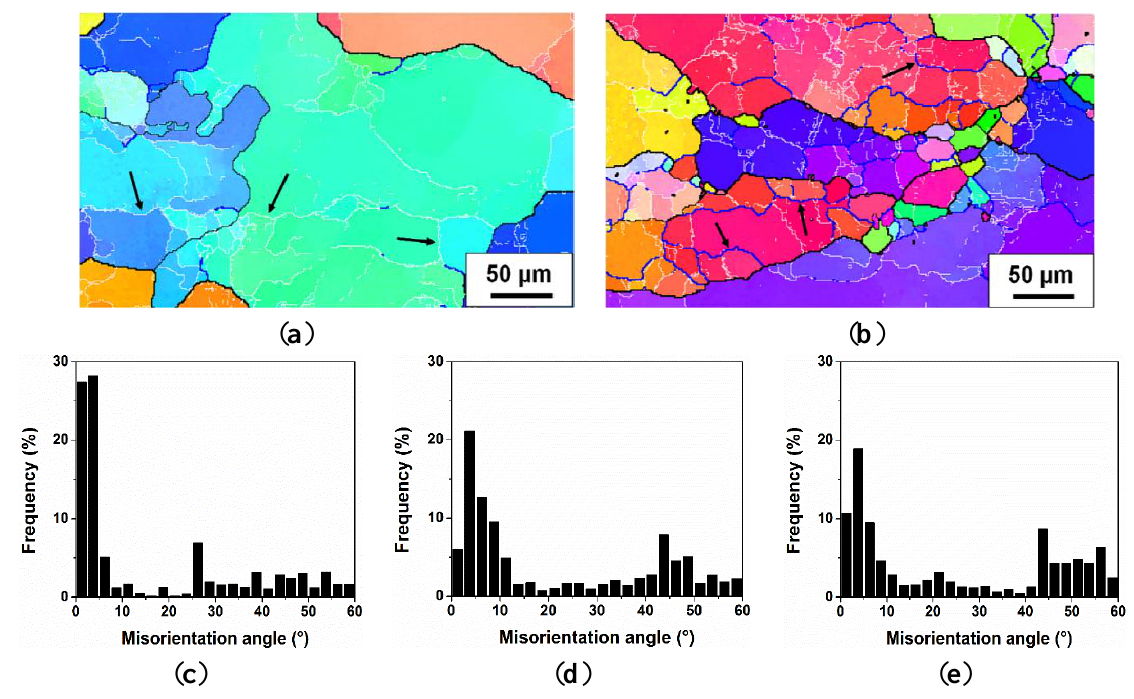
Figure 13. Orientation imaging maps of the alloy deformed at 450 °C and 0.001s −1 with the true strain of: ( a ) 0.3 and ( b ) 0.5; misorientation distribution at the true strain of: ( c ) 0.3, ( d ) 0.5 and ( e )